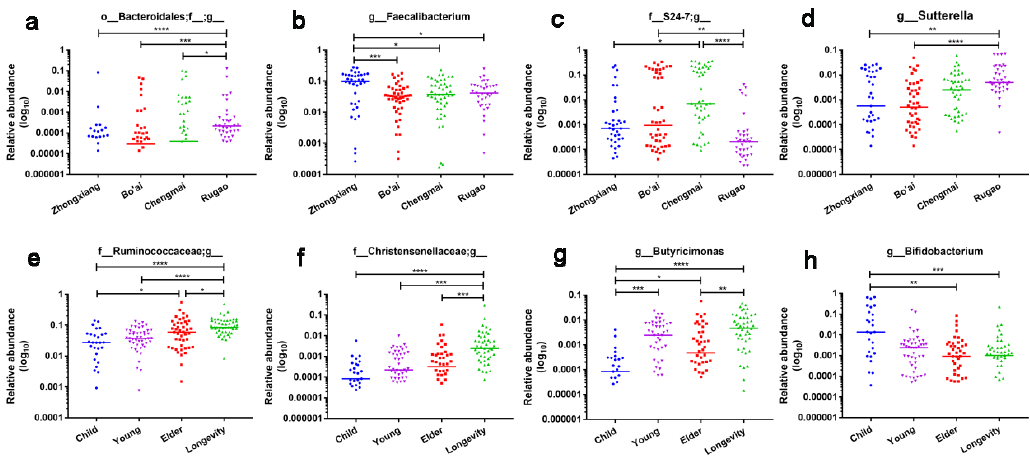
Figure 7. The genera that distribute differently in samples grouped by age ( a – d ) and region ( e – h ). The colored lines represent the median of each column. * indicates that the difference is significant. * p < 0.05, ** p < 0.01, *** p < 0.001, **** p < 0.0001.